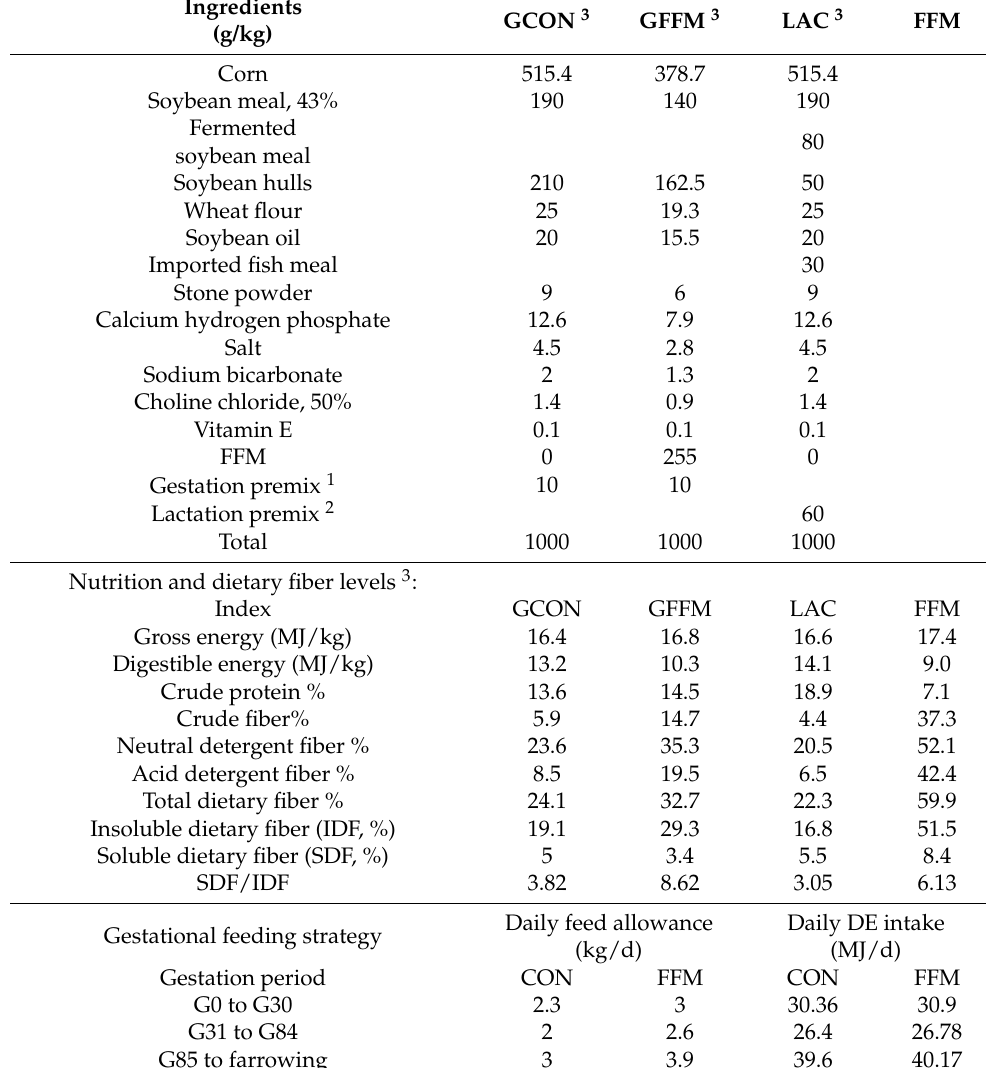
Table 1. Compositions and nutritive value of sow diets and FFM-containing feed and the gestational feeding